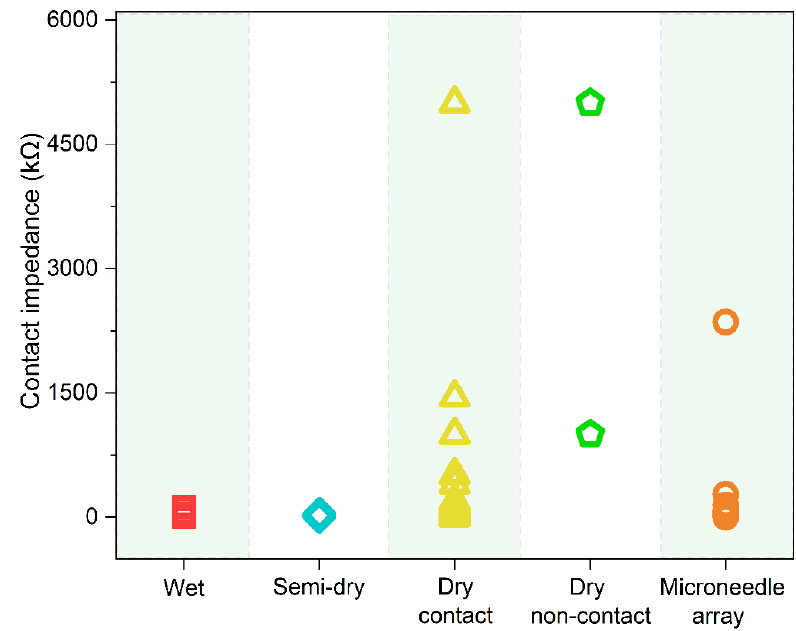
Figure 3. The electrode ‐ skin contact impedance of wet electrodes (Data derived from [52–58].), semi